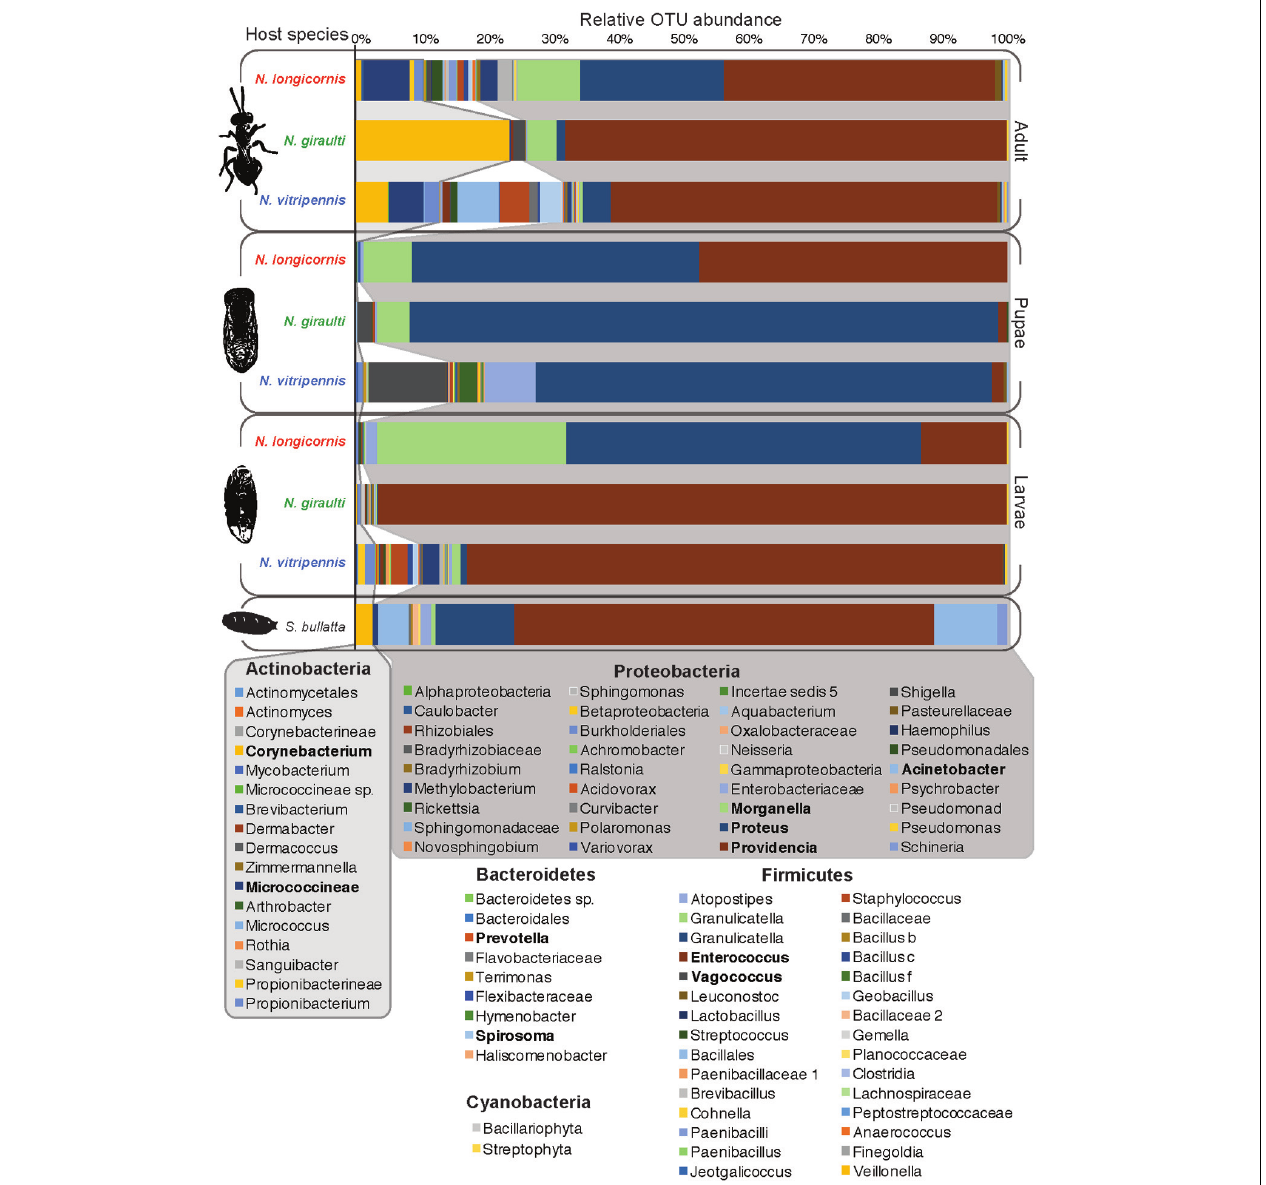
FIGURE 4 | The relative abundance of bacterial OTUs observed in male Nasonia throughout development (Brucker and Bordenstein, 2013). The OTUs represented across the three Nasonia species and their S. bullata fly host are dominated by Actinobacteria, Firmicutes, and especially Proteobacteria. Three genera, Providencia, Proteus, and Morganella , are particularly dominant across all samples. However, their relative abundances differ according to host species and developmental stage. The unparasitized S. bullata fly host is similarly dominated by Proteobacteria, specifically the genus Providencia . Emboldened OTUs are observed at higher frequencies in one or more samples. It is important to note that many of the rarer OTUs have also been observed in other studies (Brucker and Bordenstein, 2012b and personal communication).